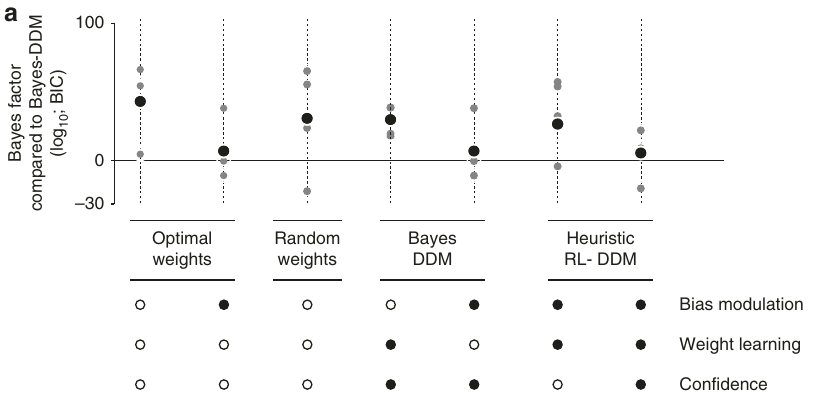
Fig. 7 Bayesian model comparison. a Model comparison between different family of models against optimal model (Bayes-DDM) using Bayes factor. Although the models were only fi tted on the mean psycho- and chronometric function, the quality of the fi tted data were evaluated considering an objective function additionally takes each model ’ s prediction of the conditional psychometric functions regarding previous reward into account (see Methods for details). Here we depict: two optimal DDM that do not learn weights, one with trial-by-trial bias modulation and one without; a random weights model in which stimulus-to-bound weights fl uctuate from trial to trial stochastically; two simpli fi ed versions of Bayes-DDM: one without bias modulation and another without weight learning; and two heuristic models in which we implement a network that mimics a DDM that learns the stimulus-to-choice map through Reinforcement learning (RL-DDM), being one of them without con fi dence weighted learning. The gray dots show the Bayes factor for individual rats, and the black dots the Bayes factors for the fi ts using the accumulated data across all rats (adjusted for the increased number of trials). For more details about these models and other versions see Methods and Supplementary